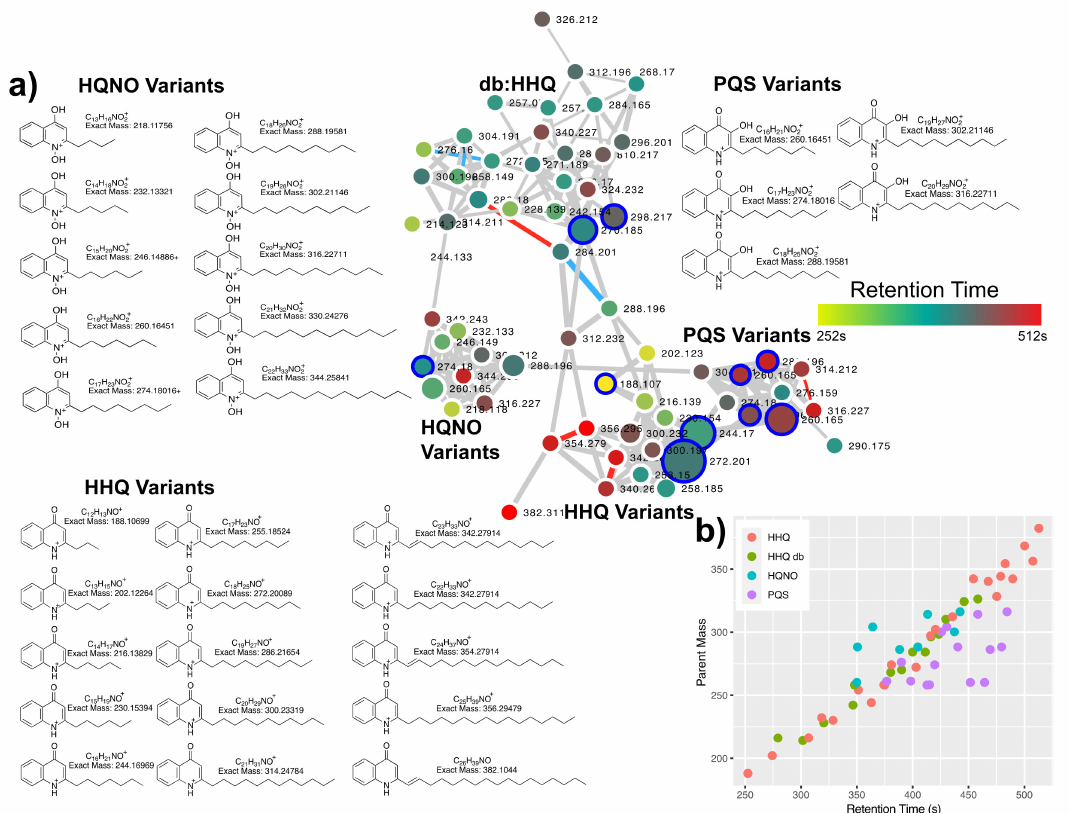
Figure 1. Quinolone diversity from P. aeruginosa clinical isolates. ( a ) Molecular network and quinolone structures for compounds identified in this study. The network nodes are colored by retention time according to the scale and sized by the number of spectra in the dataset. Edge width in the network is sized by the cosine score. Red edges represent those of a desaturation ( ∆ m / z = 2) and blue edges represent two desaturations ( ∆ m / z = 4). ( b ) Scatterplot of the parent mass and retention time in seconds of all quinolones identified. Points are colored by type of base quinolone structure as described in the